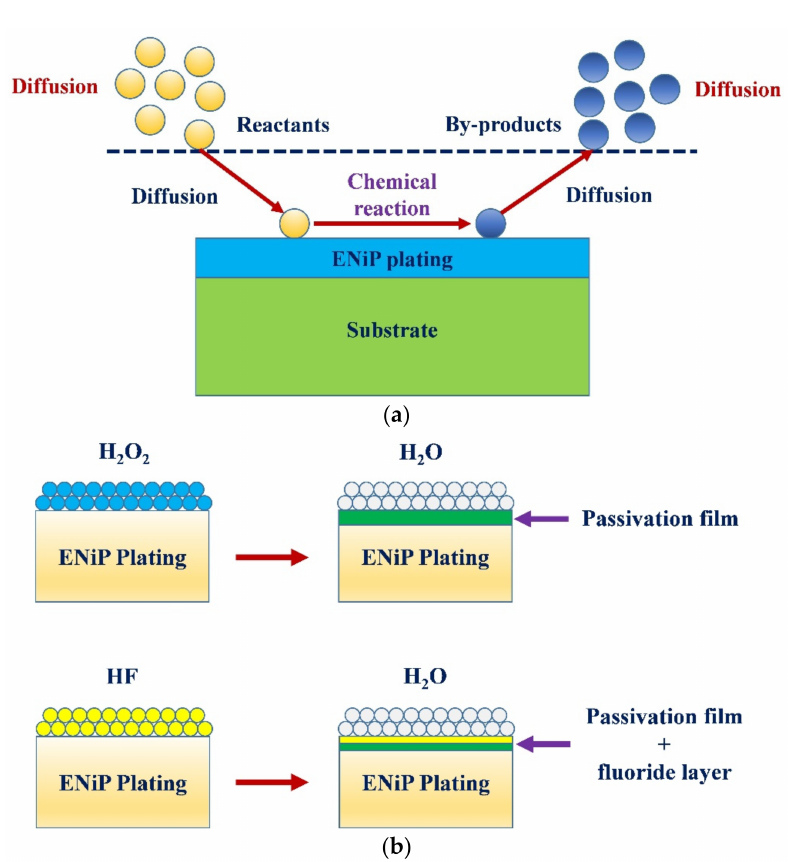
Figure 7. ( a ) Schematic of series of reactions taking place during chemical treatment, and ( b ) schematic of chemical treatment mechanism in hydrogen peroxide (H 2 O 2 ) and hydrofluoric acid (HF). As the HF is very corrosive, it is necessary to ensure that the chemical should not re- move the whole nickel plating from the surface during treatment. Therefore, concentration of HF was kept low to protect the plating on the substrate even though nickel has very high resistance to corrosion. During chemical treatment with diluted HF, a combination of passivation film and the fluoride layer was formed. HF is considered a weak acid when diluted in water. As a result, the solution had intact HF molecules and different ions of H + , HF 2 − , and F − [26]. There was no penetration and scattering with the F − ions